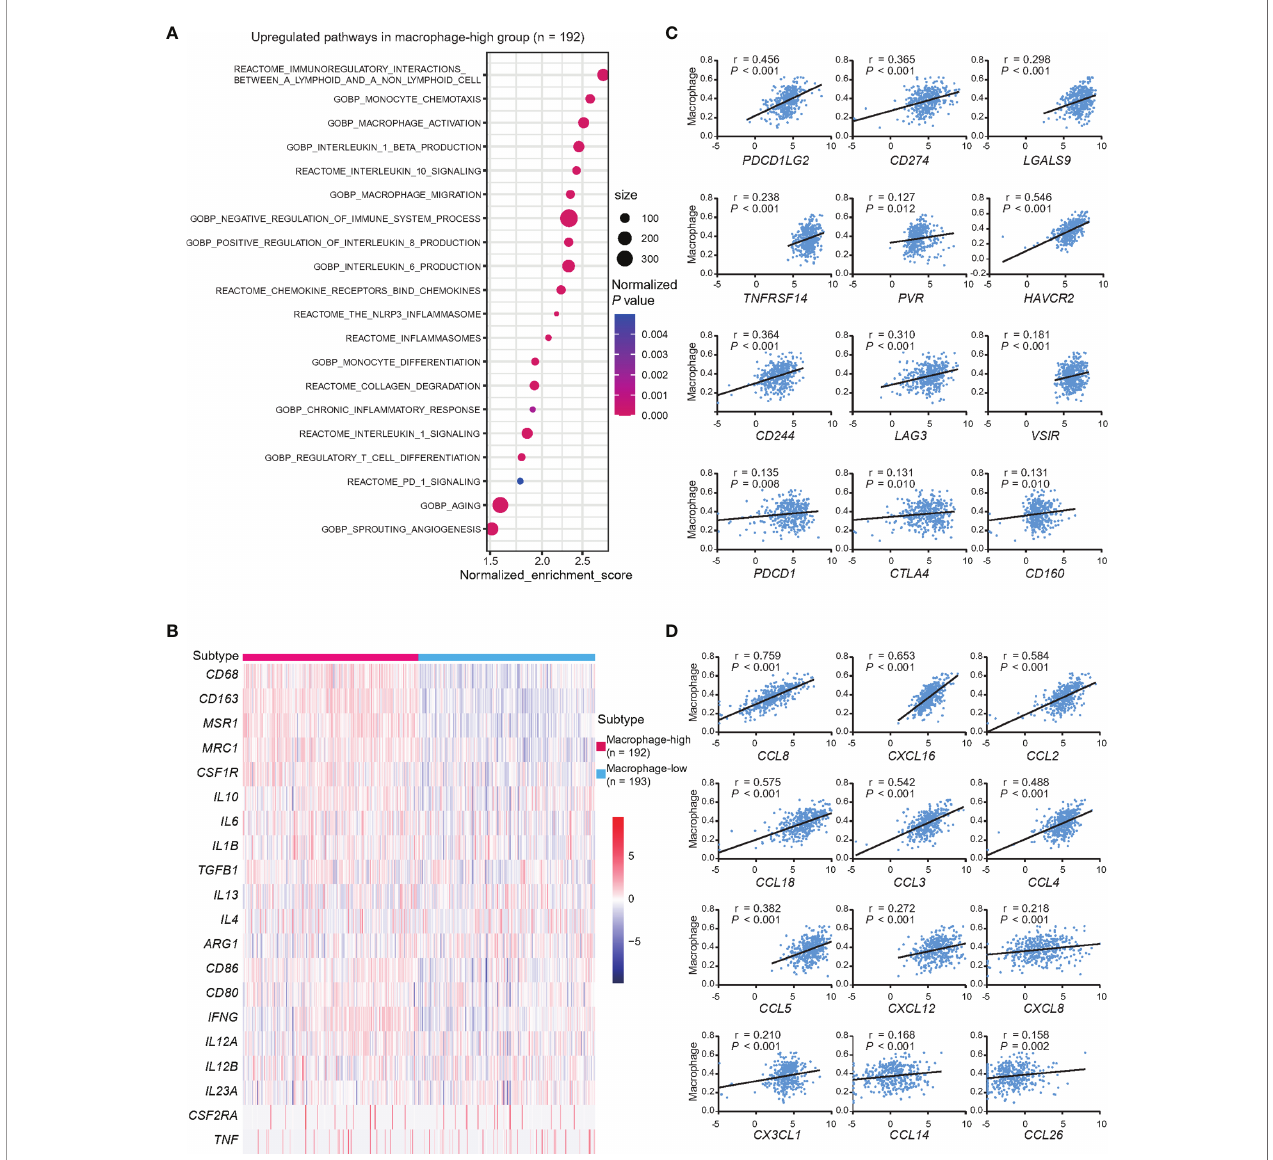
FIGURE 5 | Dysfunctions of macrophages and age at diagnosis in DLBCL. (A) Pathway enrichment analysis in macrophage-high group (n = 192), as compared to macrophages-low group (n = 193, P < 0.05). Color of points indicates normalized P -value of upregulated pathways in two groups. Size of points indicates number of genes included in each gene set. (B) Heatmap of genes associated with the markers of macrophage M2 and M1 in macrophage-high group (n = 192), as compared to macrophages-low group (n = 193). (C) Correlations between the expression of inhibitory receptors, ligands, and the abundance of macrophages. P -values and r- values were indicated in each plot. (D) Correlations between the expression of chemokines and the abundance of macrophages. P -values and r-values were indicated in each